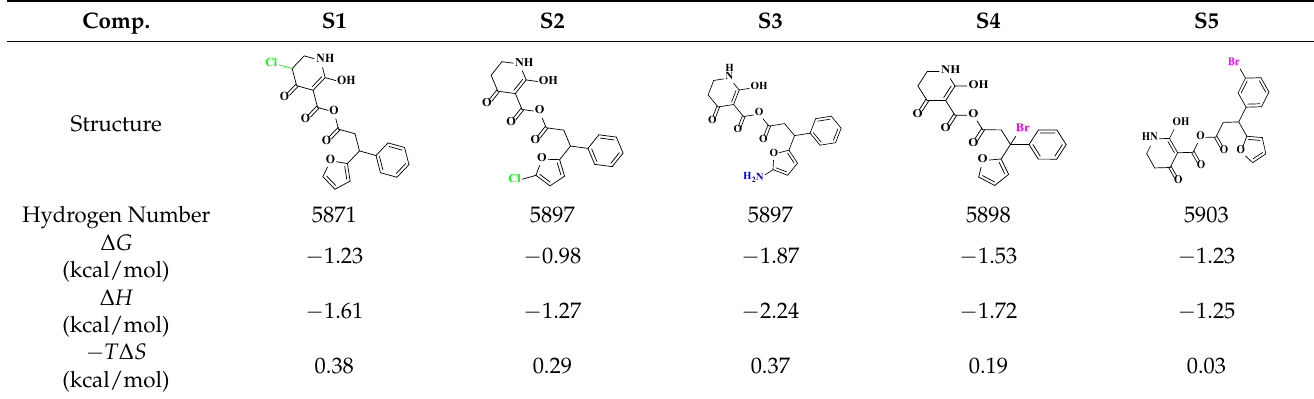
14 of 23 Figure 10. ( a ) Hydrogen serial numbers; ( b ) Heat map showing the relationship matrix between the substituent positions and substituents (darker red colors indicate compounds with better activities); ( c ) Histogram illustrating the overall result based on substituent positions, which helps to elucidate which positions possess the most potential for substitution (X: Hydrogen number, Y: Score).